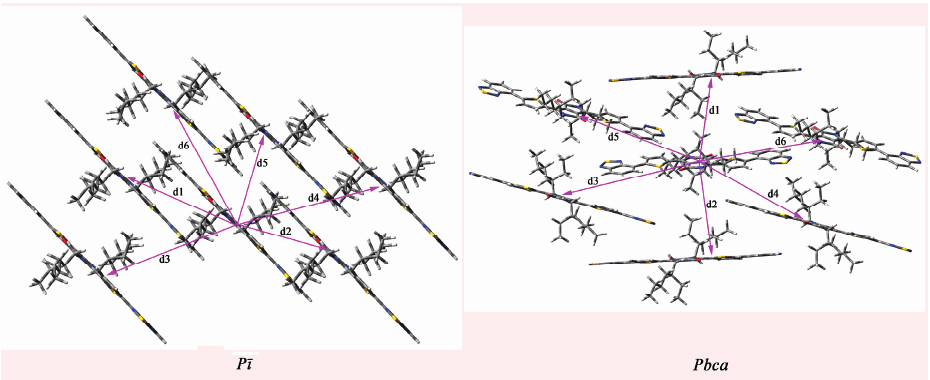
Figure 3. Herringbone structures of 1c in different space groups.